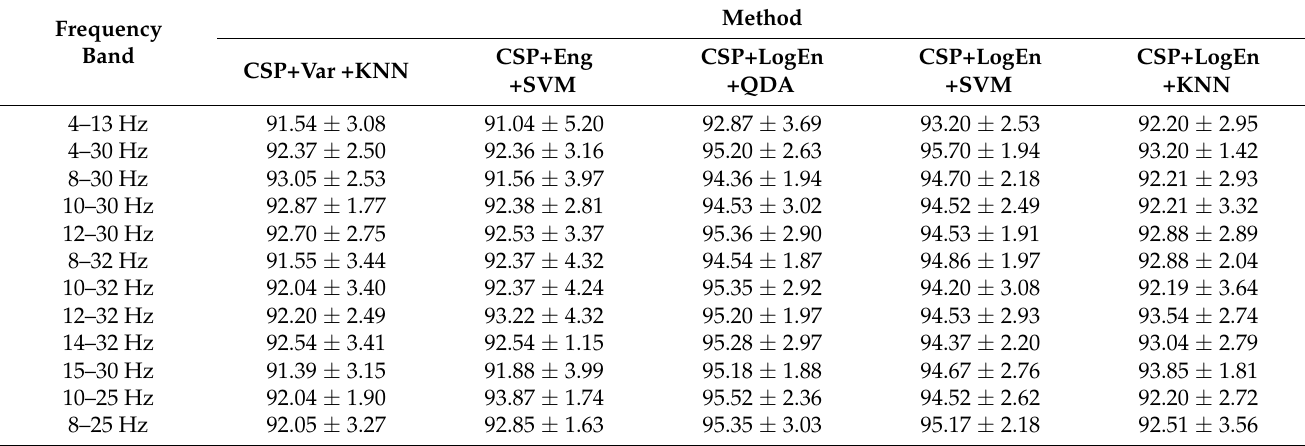
Table 10. The effect of frequency bands on classification accuracy using KNN (on–PD vs. HC).